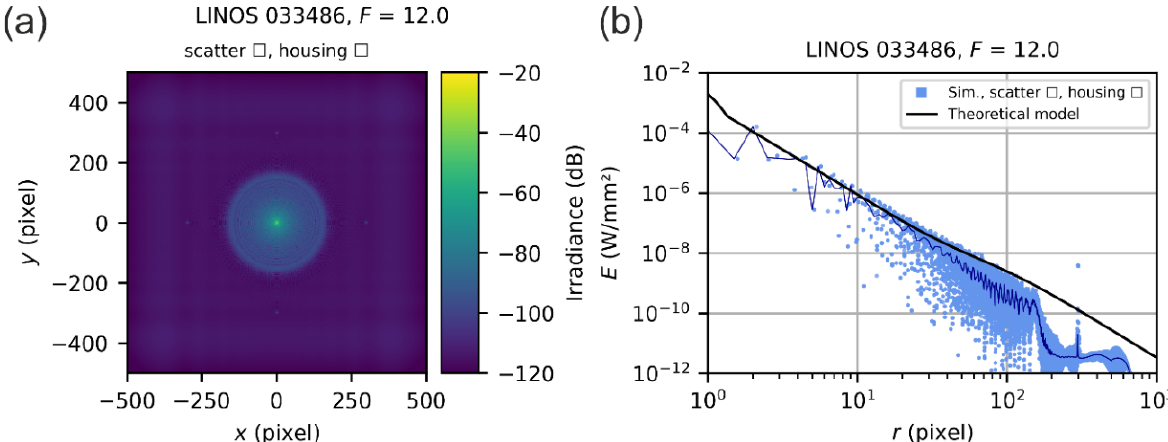
Figure 12. Simulation results for the LINOS 033486 lens setting an f-number of 𝐹 = 12 and using the diffraction-focused parameter set 3 with a high number of source rays. Only the regular rays were analyzed, scattered rays were neglected. ( a ) Results represented as an image. ( b ) Results shown as a scatter plot.